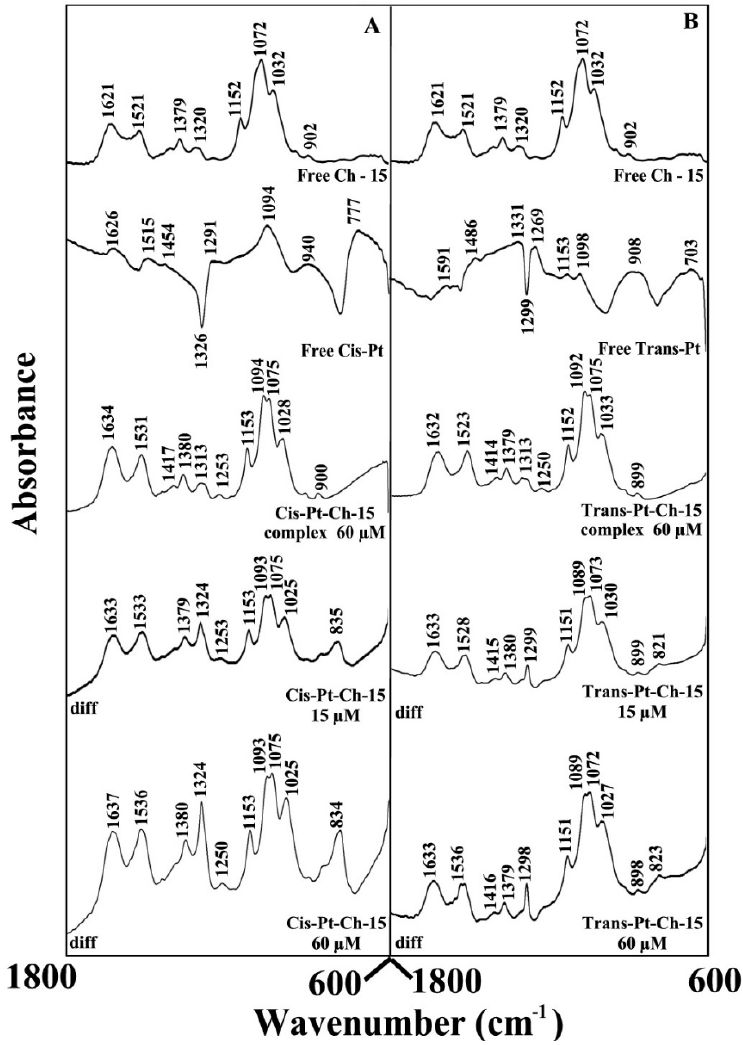
Figure 5. FTIR spectra in the region of 1800–600 cm − 1 of hydrated films (pH 5–6) for chitosan–15 kD with cis–Pt ( A ) and trans–Pt ( B ) with chitosan (60 µM) and its Pt conjugates with difference spectra (diff.) (bottom two curves) obtained at different drug concentrations (indicated on the figure).